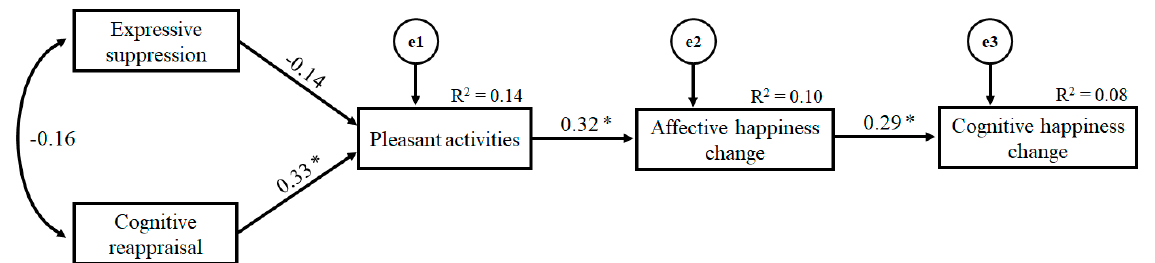
Figure 1. Graphical representation of the model including standardized path coefficients and explained variance (R 2 ). An asterisk indicates significance at the p < 0.05 level.